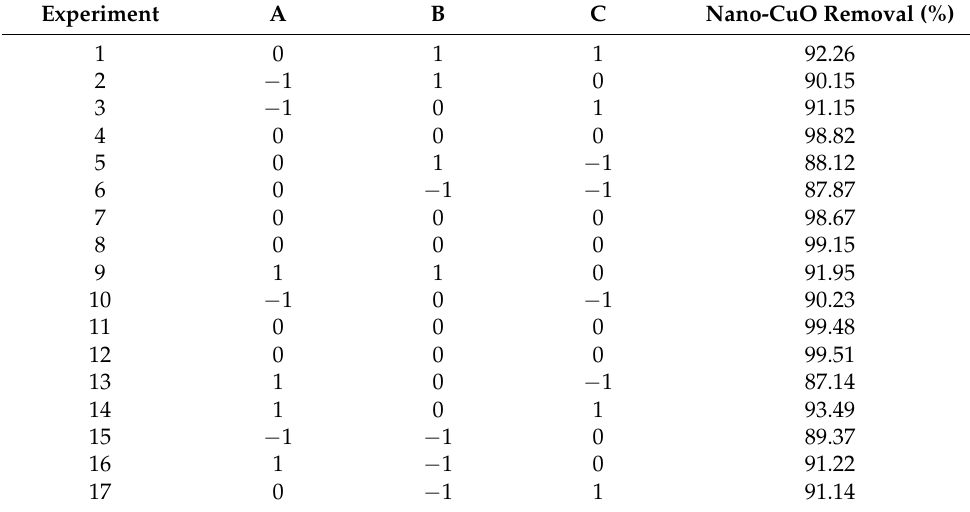
Table 2. Test design and response values for